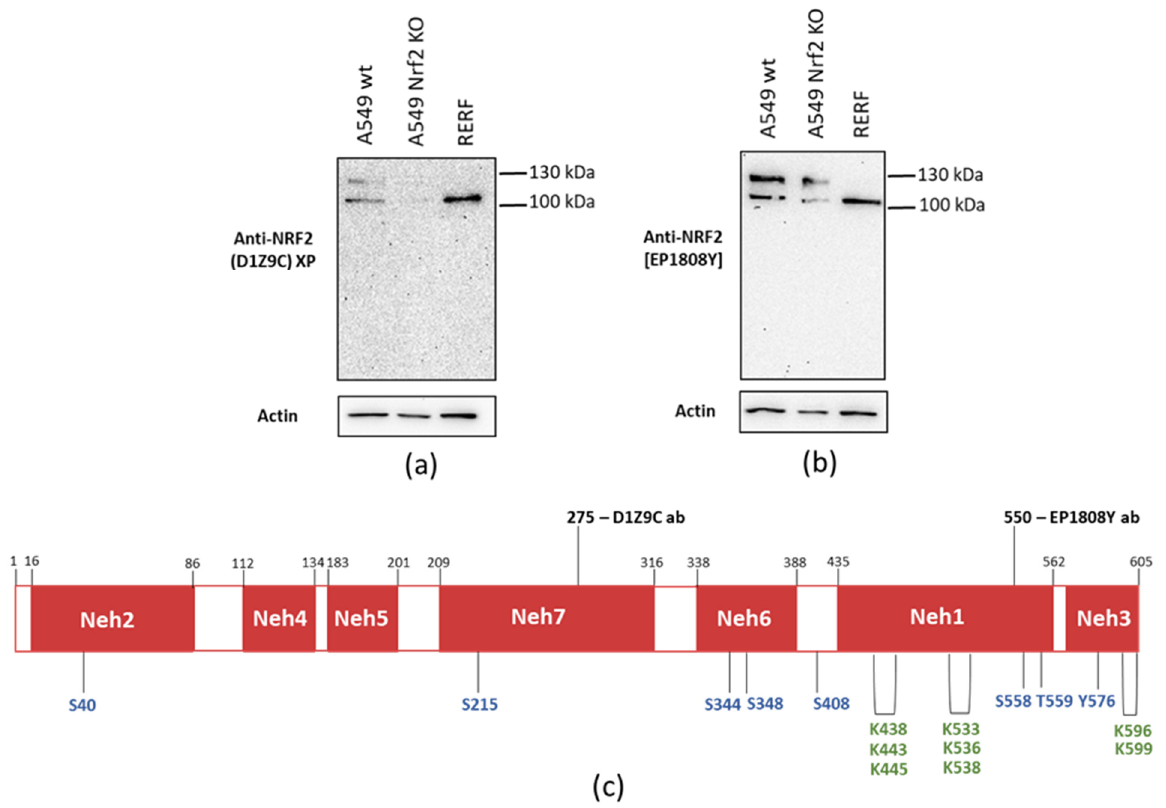
Figure 1. Nrf2 migratory pattern detected in A549 wt, A549 Nrf2 KO, and RERF cells with two monoclonal antibodies—Cell Signaling (CS) (D1Z9C) ( a ) and Abcam [EP1808Y] ( b ), ( c ) Domain structure of Nrf2 with post-translational modifications and regions recognized by Cell Signaling (CS) (D1Z9C) and Abcam [EP1808Y] antibodies. Precise epitope sequence is disclosed, for Abcam EP1808Y it is known to be localized in the C-terminus, surrounding 550 aa and for CS—in the proximity of 275 Ala. Post-translational modifications of Nrf2 residues are marked—phosphorylation in blue (Ser40, Ser215, Ser344, Ser348, Ser408, Ser558, Thr559, and Tyr576) and acetylation in green (Lys438, Lys443, Lys445, Lys533, Lys536, Lys538, Lys596, and Lys599).